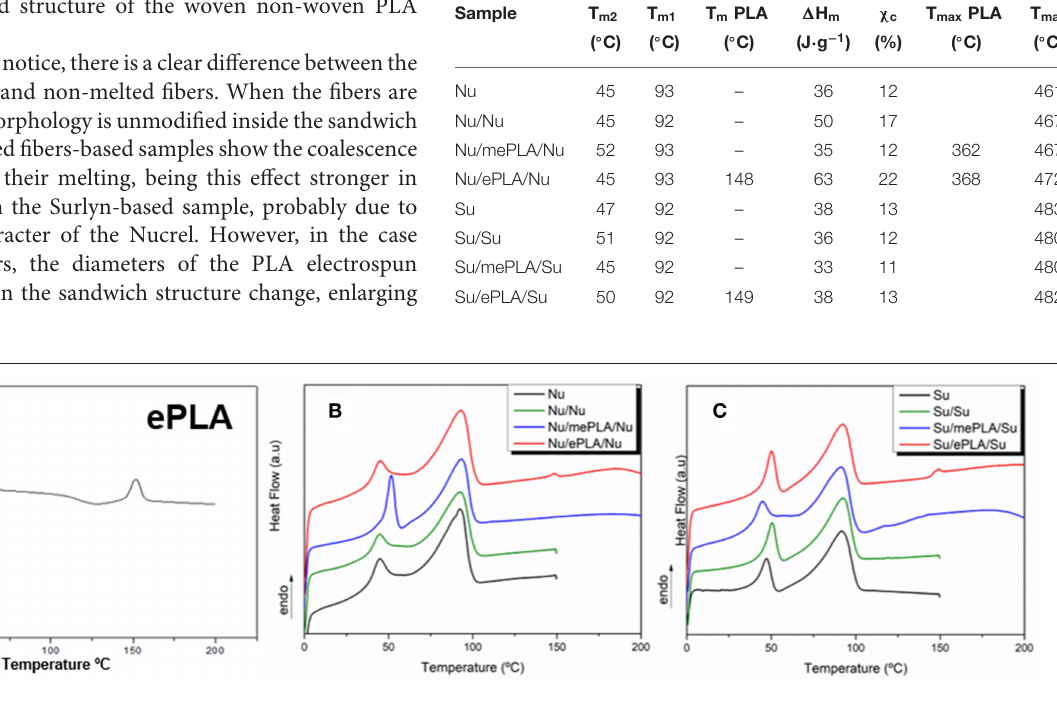
FIGURE 5 | First heating scan of DSC analyses for all the processed materials and their multilayer composites with PLA microfibers. (A) ePLA, (B) Nucrel-based multilayers composites, and (C) Surlyn-based multilayer composites.